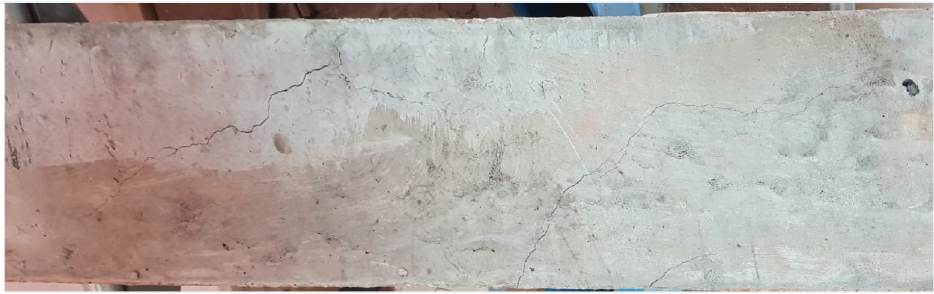
Figure 7: Crack pattern of steel fiber